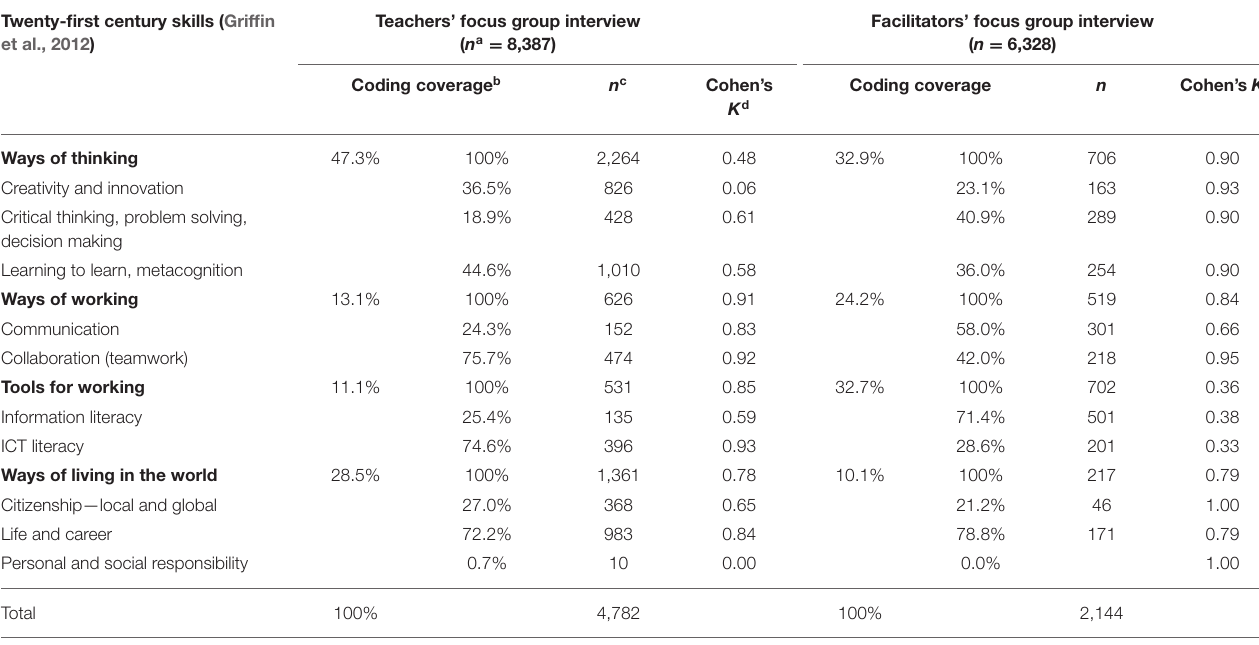
TABLE 4 | Summary of twenty-first century skills identified in the focus group interviews. Twenty-first century skills (Griffin et al., 2012